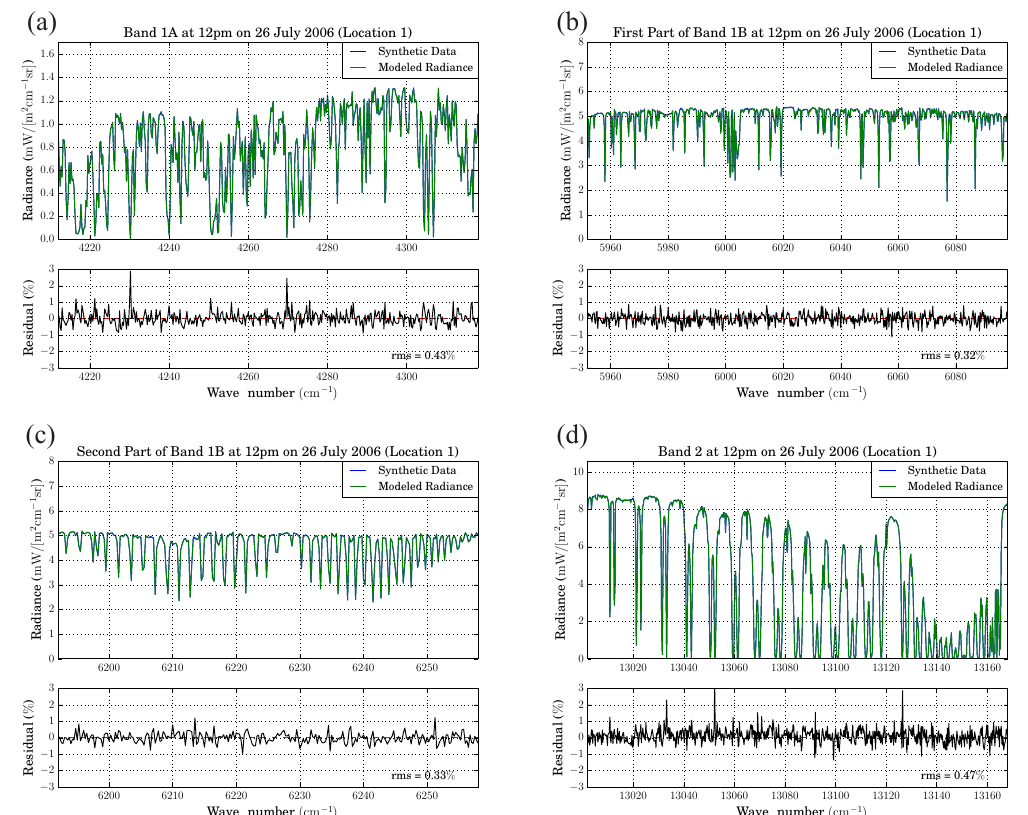
Figure 6. A sample spectral fit and residuals from a simulated clear-sky retrieval on 26 July 2006 at Location 1. The root-mean-square (rms) values of the residuals are between 0.32 and